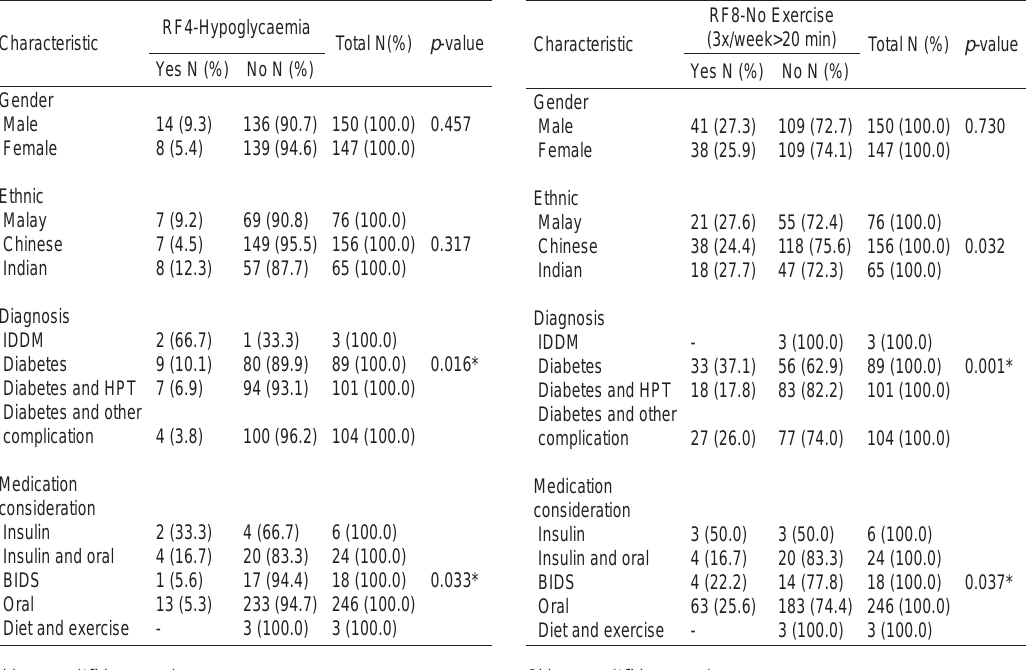
TABLE 10. Characteristic determination of RF8-No Exercise (3x/week>20 min) in study